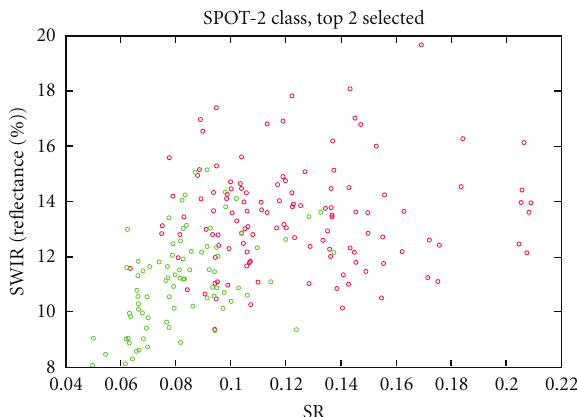
Figure 5: Values for the simple ratio and percent reflectance in the SWIR for individual trees infested or not infested with balsam woolly adelgid. Reflectances and band ratios were computed by integrating the narrow band data to the SPOT5-HRVIR band equivalent reflectance. The two variables were selected using a stepwise discriminant analysis procedure for distinguishing infested from noninfested trees.